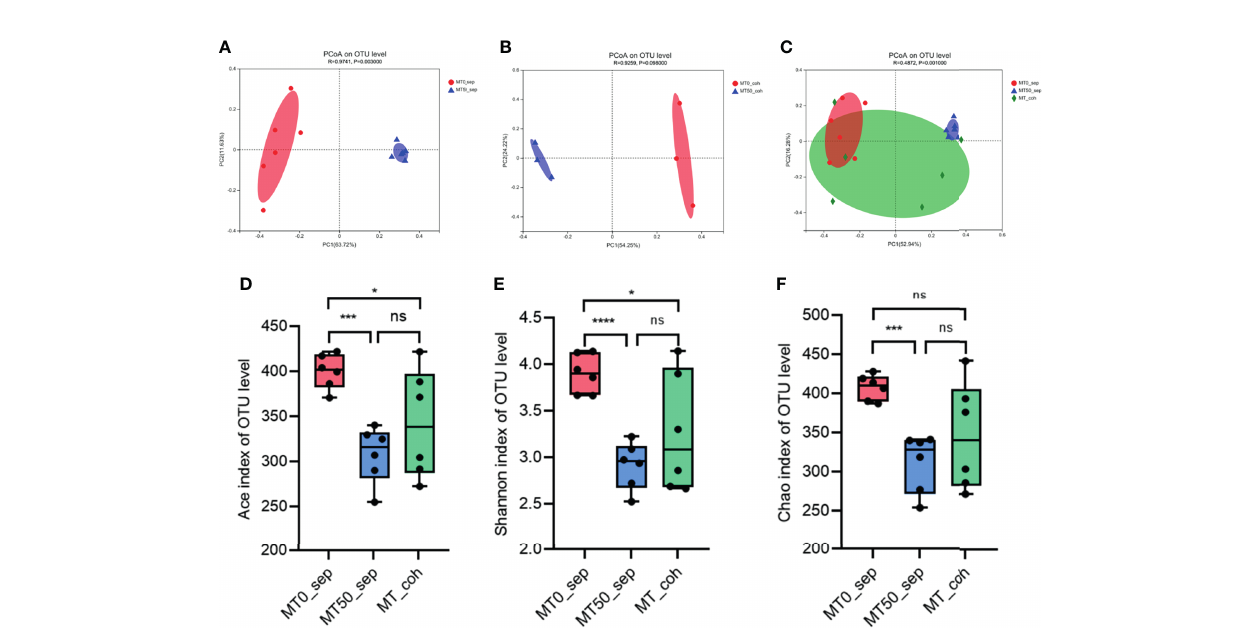
FIGURE 5 | Melatonin alters microbiota composition in alpha and beta diversity. (A) Principal coordinate analysis (PCoA) of fecal microbiota in separately housed mice treated or untreated with melatonin for 7 days. (B) PCoA of fecal microbiota in co-housed mice treated or untreated with melatonin for 7 days. (C) PCoA of fecal microbiota among separately housed melatonin-treated mice, separately housed melatonin-untreated mice, and co-housed mice. PCoA is based on binary Jaccard distance. ANOSIM and 999 times permutation tests were utilized. (D – F) Shannon, Chao, and Ace indices of operational taxonomic unit (OTU) levels. Data are expressed as mean ± SD; statistical signi fi cance was determined by a two-sided Student ’ s t-test or one-way ANOVA. * p < 0.05; *** p < 0.001; **** p < 0.0001. ns, no signi fi cance.